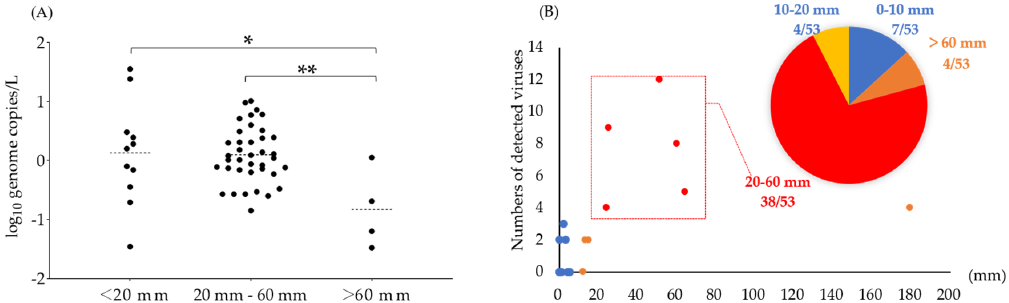
Figure 4. Relationship between precipitation and virus detection. ( A ) Correlation between viral loads ( x -axis) and accumulative precipitation ( y -axis). ( B ) Detection rates of viruses in response to 10-day accumulative precipitation.